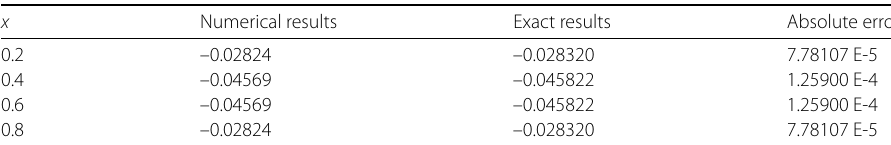
Table 4 The numerical results for the third issue available at y = 0.4, x , y ∈ [0,1]